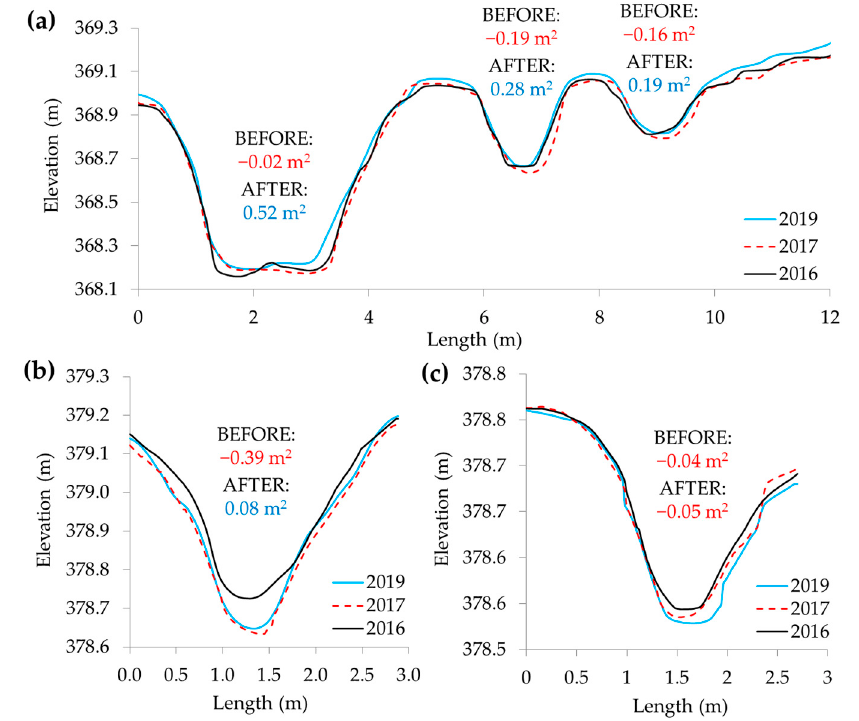
Figure 12. Cross sections (CSs) indicated in Figure 11: ( a ) CS-1, ( b ) CS-2, and ( c ) CS-3, before the installation of the restoration measures (2016) and afterwards (2017–2019).